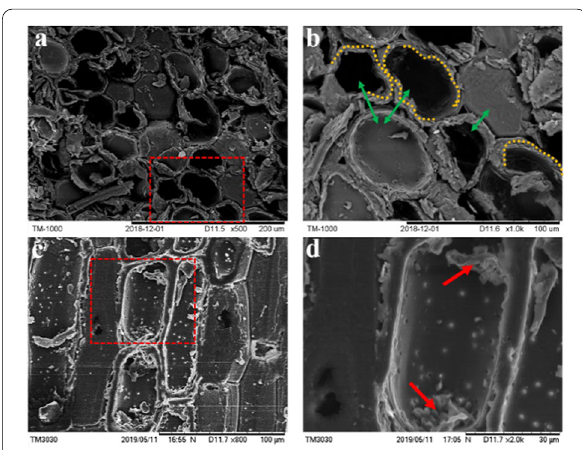
Fig.2 SEM images of oil heat-treated bamboo samples at 200 °C for 6 h. a , b cross section, c , d longitudinal section